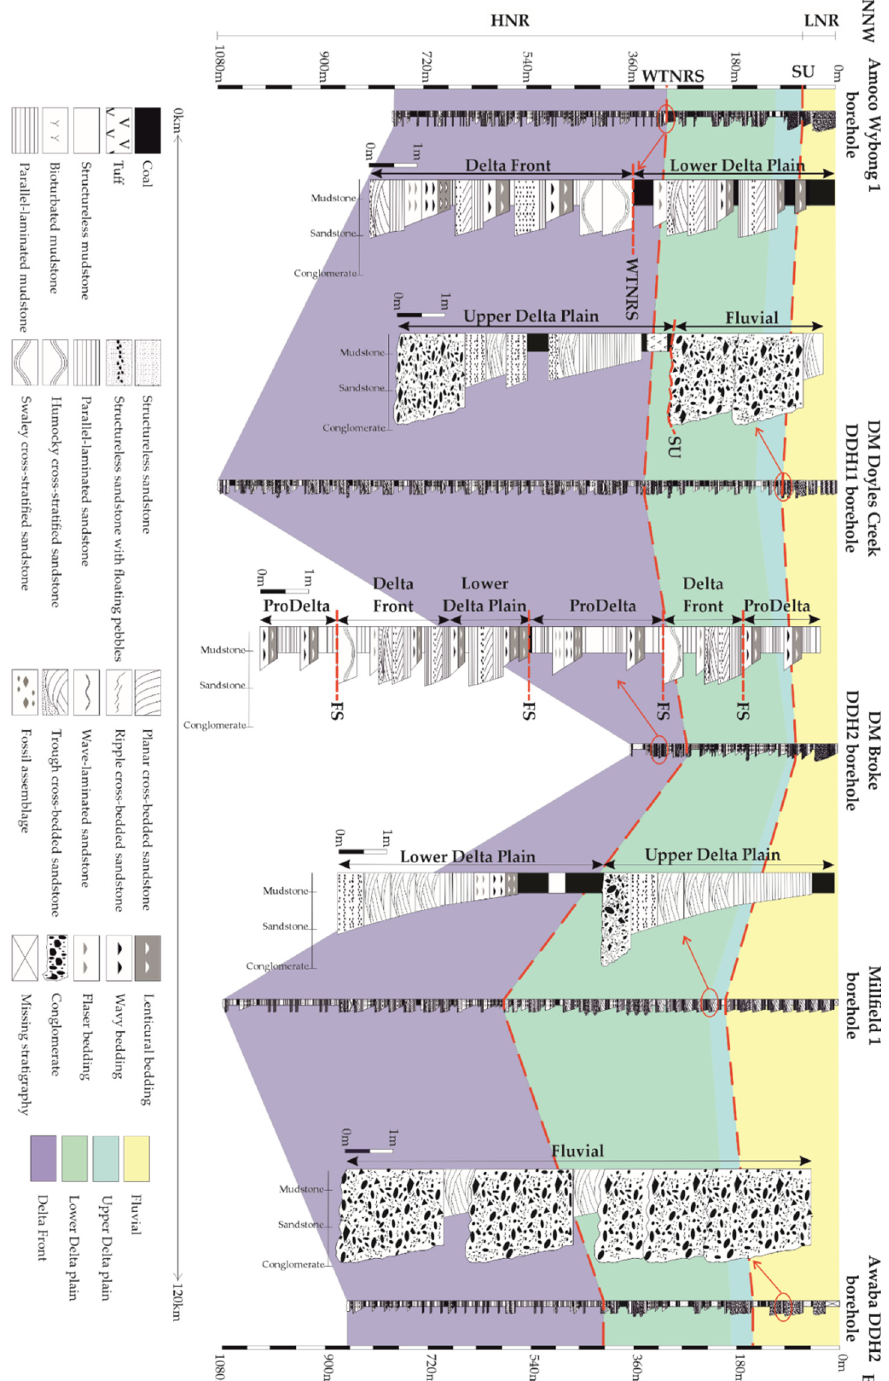
Figure 12. Correlative cross-section of the NSB illustrating the up-sequence evolution of the different depositional envi- ronments and sub-environments. The progradation of the fluvio-deltaic system and the gradual shallowing of the basin is indicated by the evolution from prodelta to delta-front, delta-plain, and finally fluvial deposits. Note that both deltaic and fluvial deposits indicate deposition during relative sea-level rise (HNR and LNR respectively), which is interrupted by relative sea-level fall (FR) at the boundary between the two systems. Abbreviations: HNR: Highstand normal regression, LNR: Lowstand normal regression, FR: Forced regression, SU: Subaerial unconformity, WRNRS: Within trend normal regression surface, FS: Flooding surface.